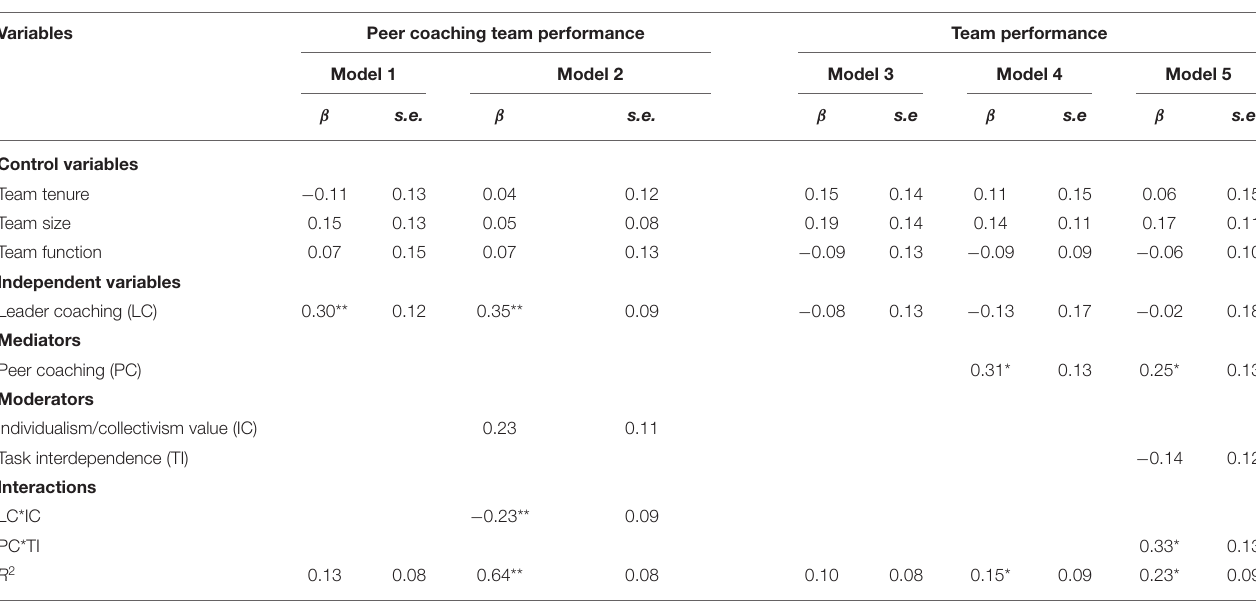
TABLE 2 | Path analytical results.